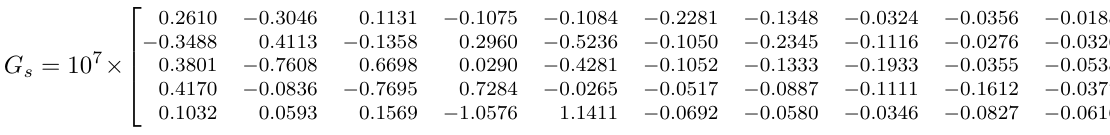
Figure 6: State-feedback gain matrix G